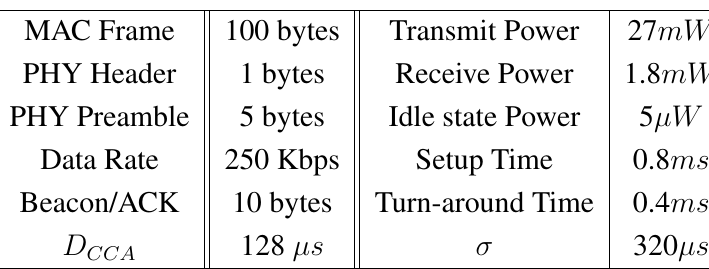
Table 2. Simulation Parameters for PHY2 (2.4